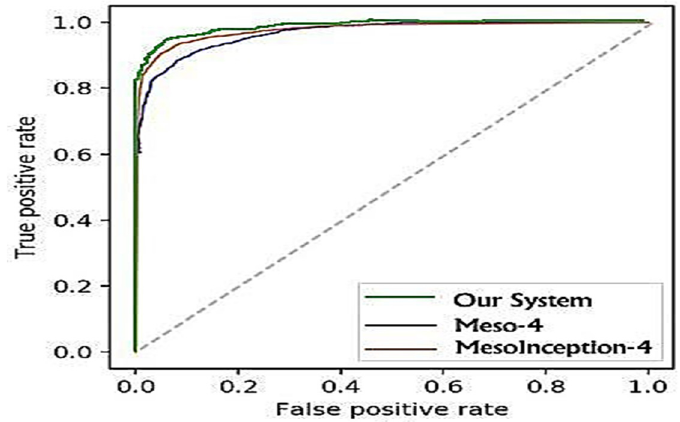
Figure 10. ROC curves of the evaluated classifiers on the DeepFake dataset.